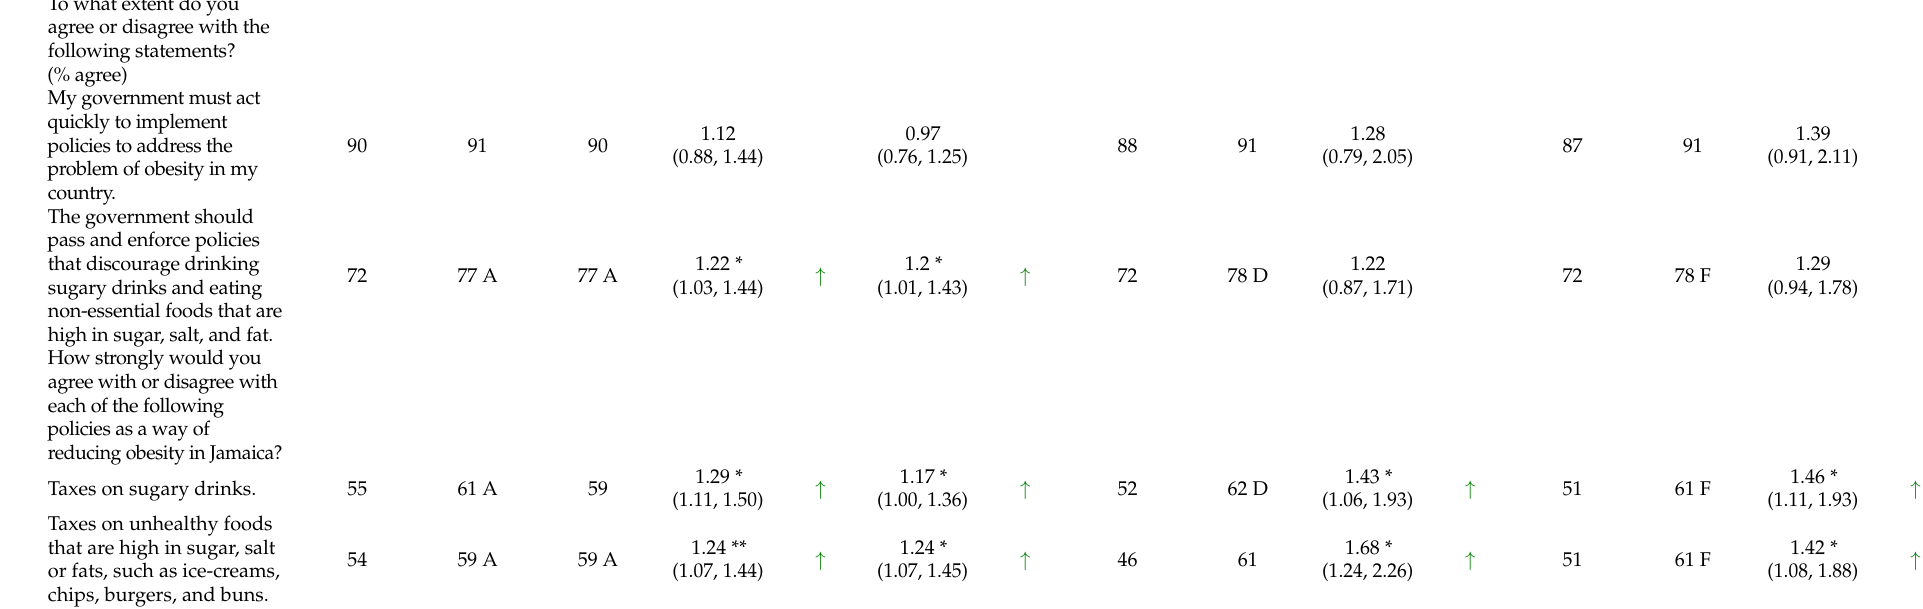
Table 6. Support for the government’s efforts regarding obesity and sugary drinks among respondents in the pre-campaign, post-campaign I, and post-campaign II periods including a comparison of evaluation survey’s respondents who were aware and unaware of the campaign. Post- Mid- Mid-Campaign Survey Post-Campaign Survey Post-Campaign Mid-Campaign Baseline Campaign Campaign Survey Survey Survey Unaware Aware Unaware Aware Survey Survey CI)( n = 1430) ( n = 1571) ( n = 1500) Ref: Baseline Survey ( n = 239) ( n = 1332) ( n = 271) ( n = 1229) Adj. OR ˆ Adj. OR ˆ B C Adj. OR ˆ (95% CI) (95% (95%